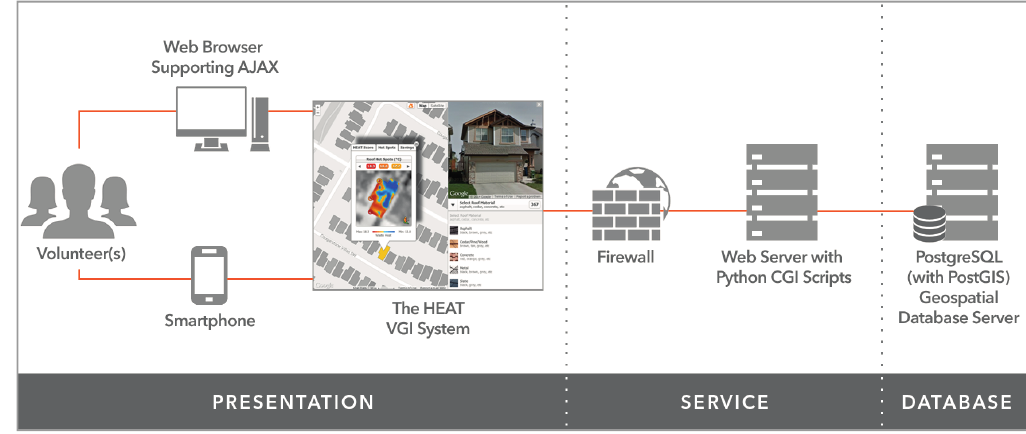
Figure 1. The three-tier system architecture used for developing HEAT’s VGI